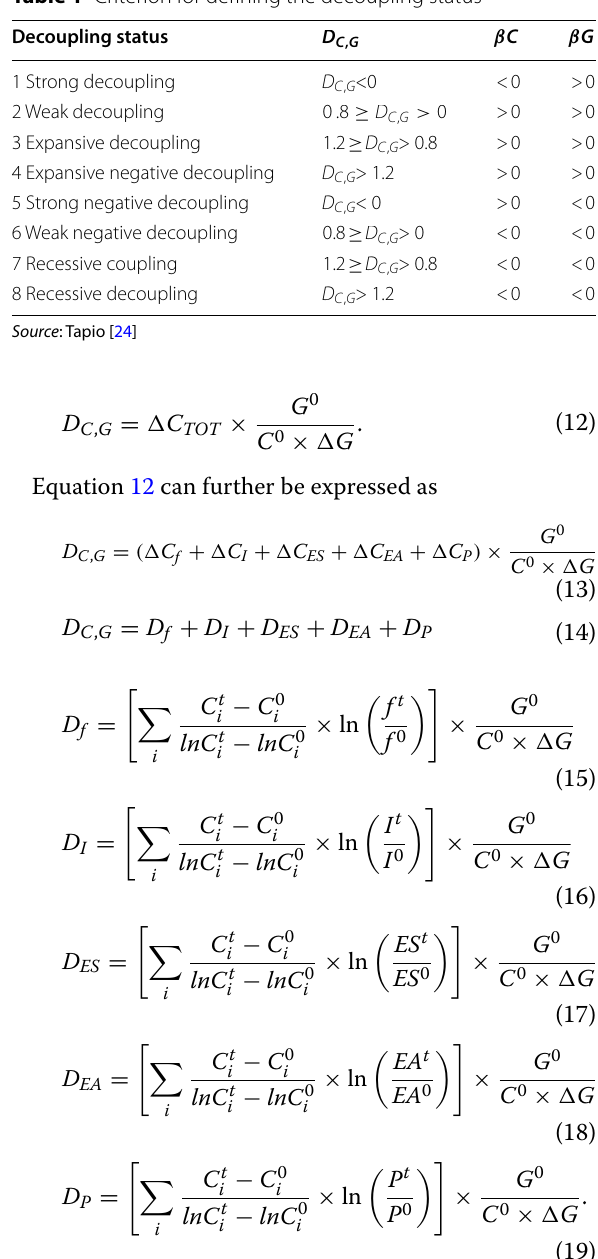
Table 1 Criterion for defining the decoupling